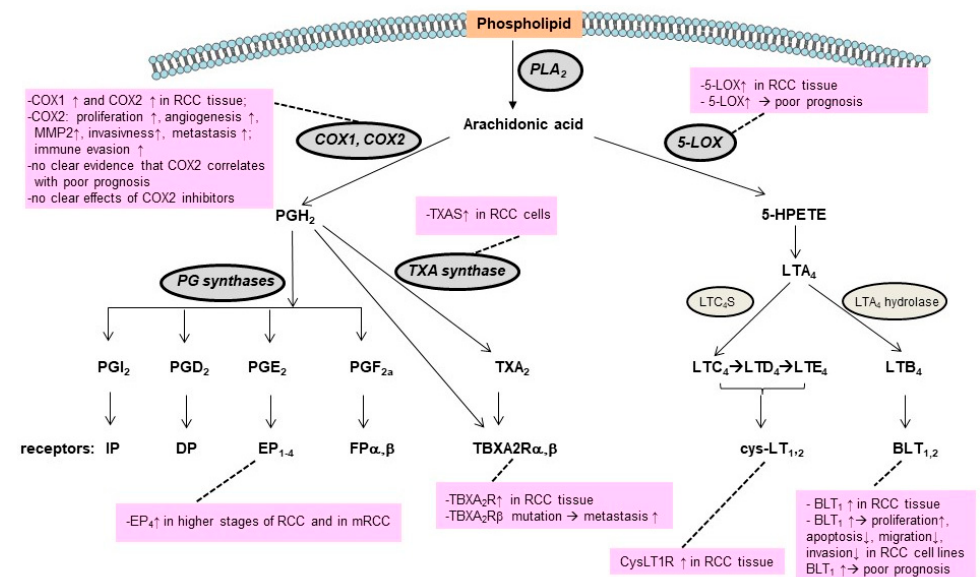
Figure 3. Prostaglandins and leukotrienes synthesis pathways and receptors involved. Changes reported for RCC are highlighted in pink boxes. For abbreviations, see text.